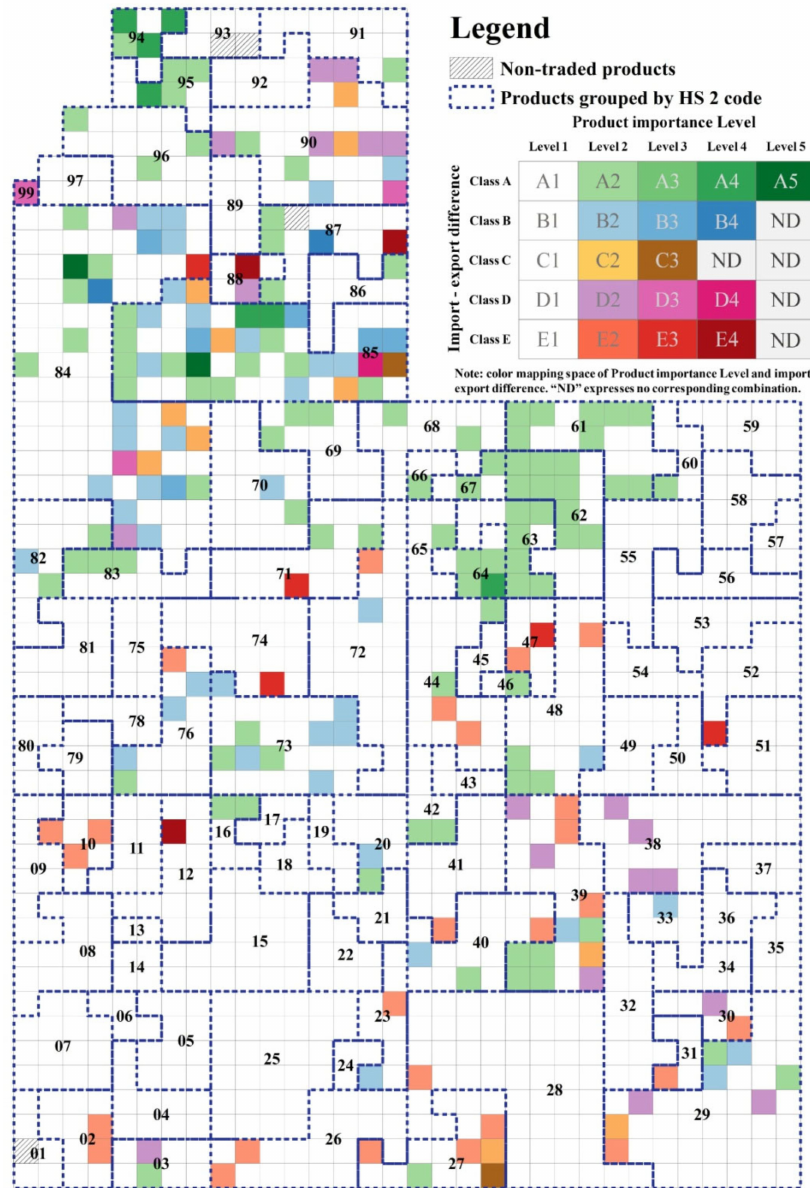
Figure 6. Spatial pattern of product import–export di ff erence class. Only the import–export di ff erence class information about high-level products (importance level > 1) were expressed in this figure. See Figure A4 for detailed